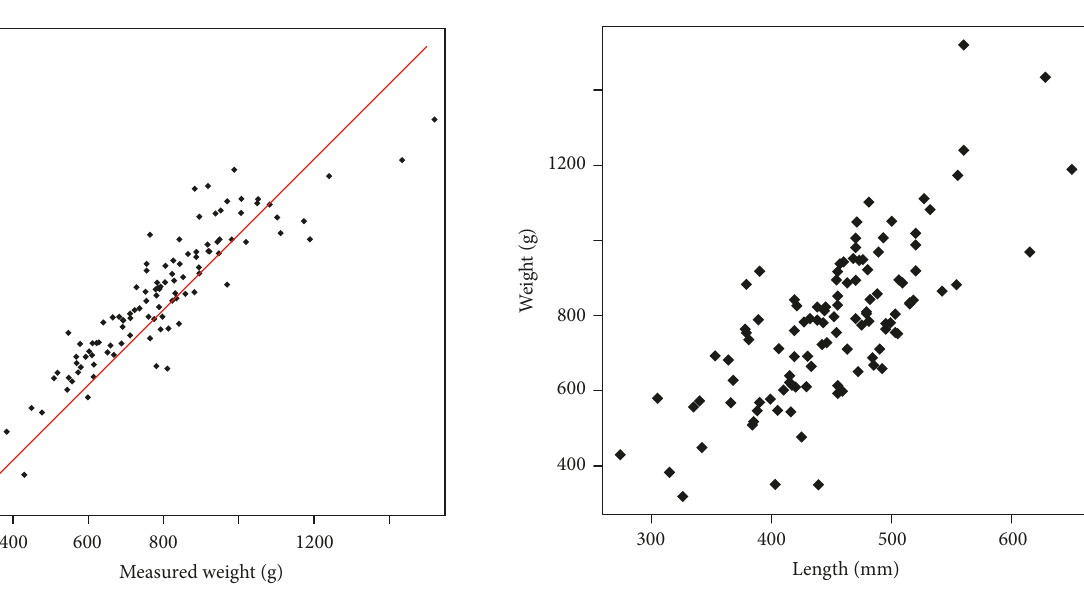
Figure 11: The scatter plot of the length and weight of the 111 yams in this